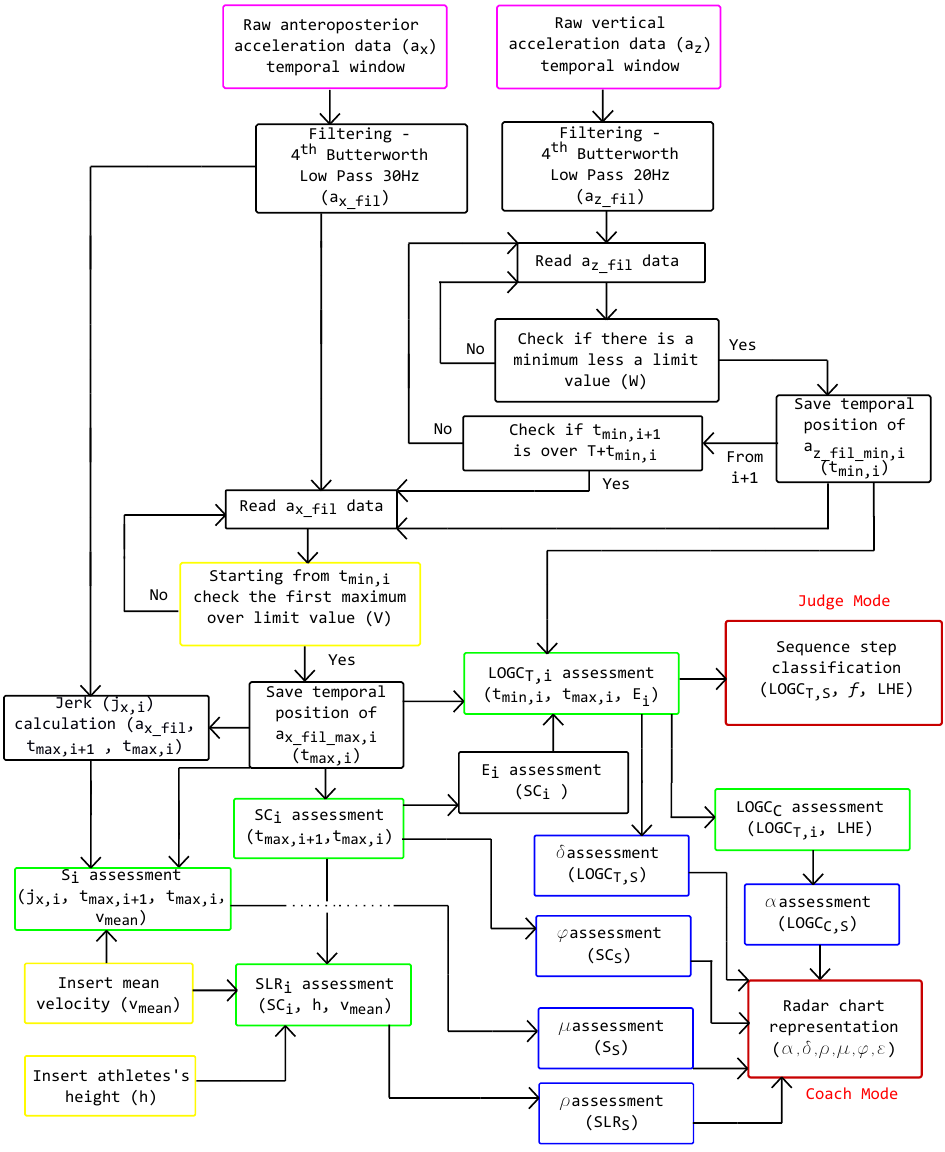
Figure A1. Flow chart of the data processing and